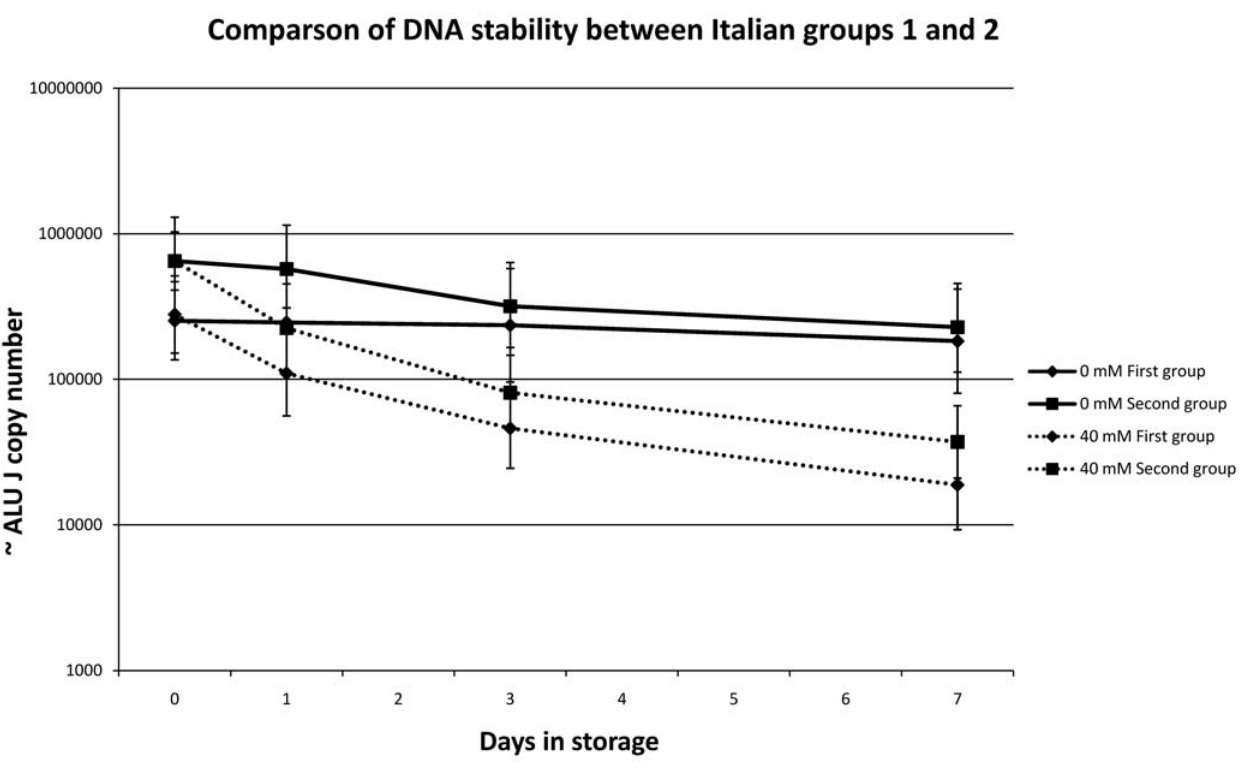
Figure 5. Comparison of DNA stability between Italian groups 1 and 2. Stability of human DNA in urine over 7 days compared between groups 1 and 2 demonstrate that the stability trend observed for the second analyses is highly consistent with the first. Specifically the degradation when urine is stored with EDTA is almost identical between the two groups. Geometric means + / 2 95% confidence intervals are plotted for each treatment.